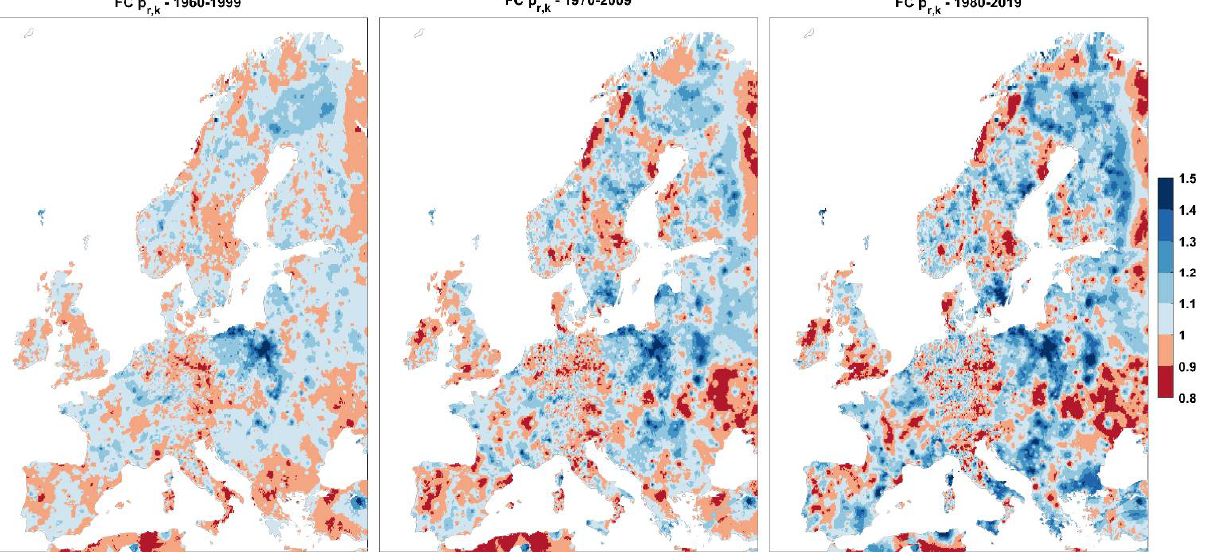
Figure 11. Factors of change maps of daily precipitation characterized by an annual probability of exceedance p = 0.02, based on the E-OBS dataset.